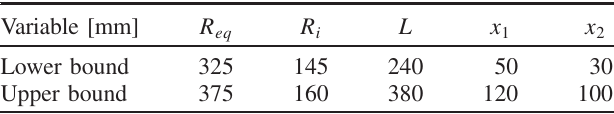
FIG. 13. A summary of Secs. II – VI, applied to a different parametrization. The methods are red and the conclusions blue. TABLE VI. Some of the local sensitivities for the rf cavity from The corresponding information for the single-cell B´ezier cavity is Fig. 10, denoted FCC in Table V. The magnitude of other PR 19 referenced in parentheses. sensitivities is below 0 . 7 MHz = mm. TABLE VII. Intervals for the single-cell B´ezier